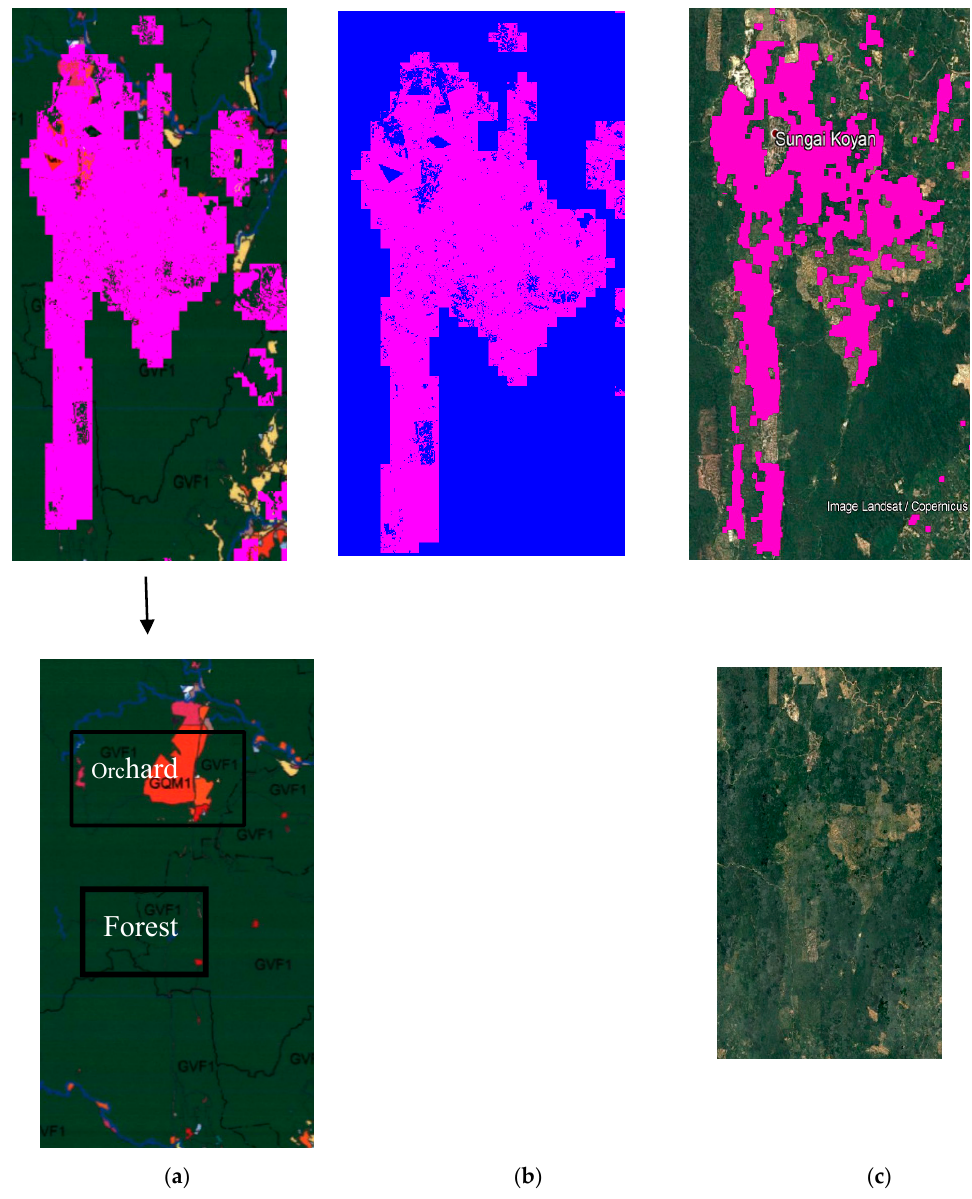
Figure 8. ( a ) Oil palm that was detected as forest by the Department of Agriculture; ( b ) oil palm that was correctly detected as oil palm in this study; ( c ) Google Earth image showing that the area is indeed oil palm.